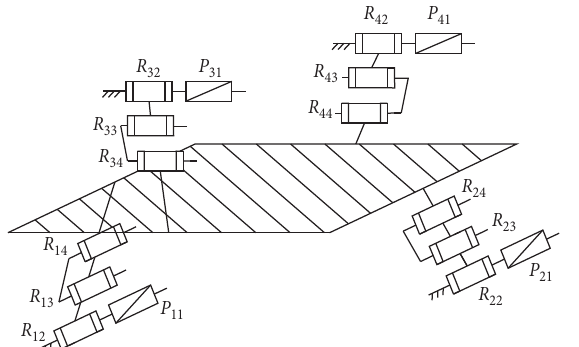
Figure 6: Diagram showing the principle of a parallel